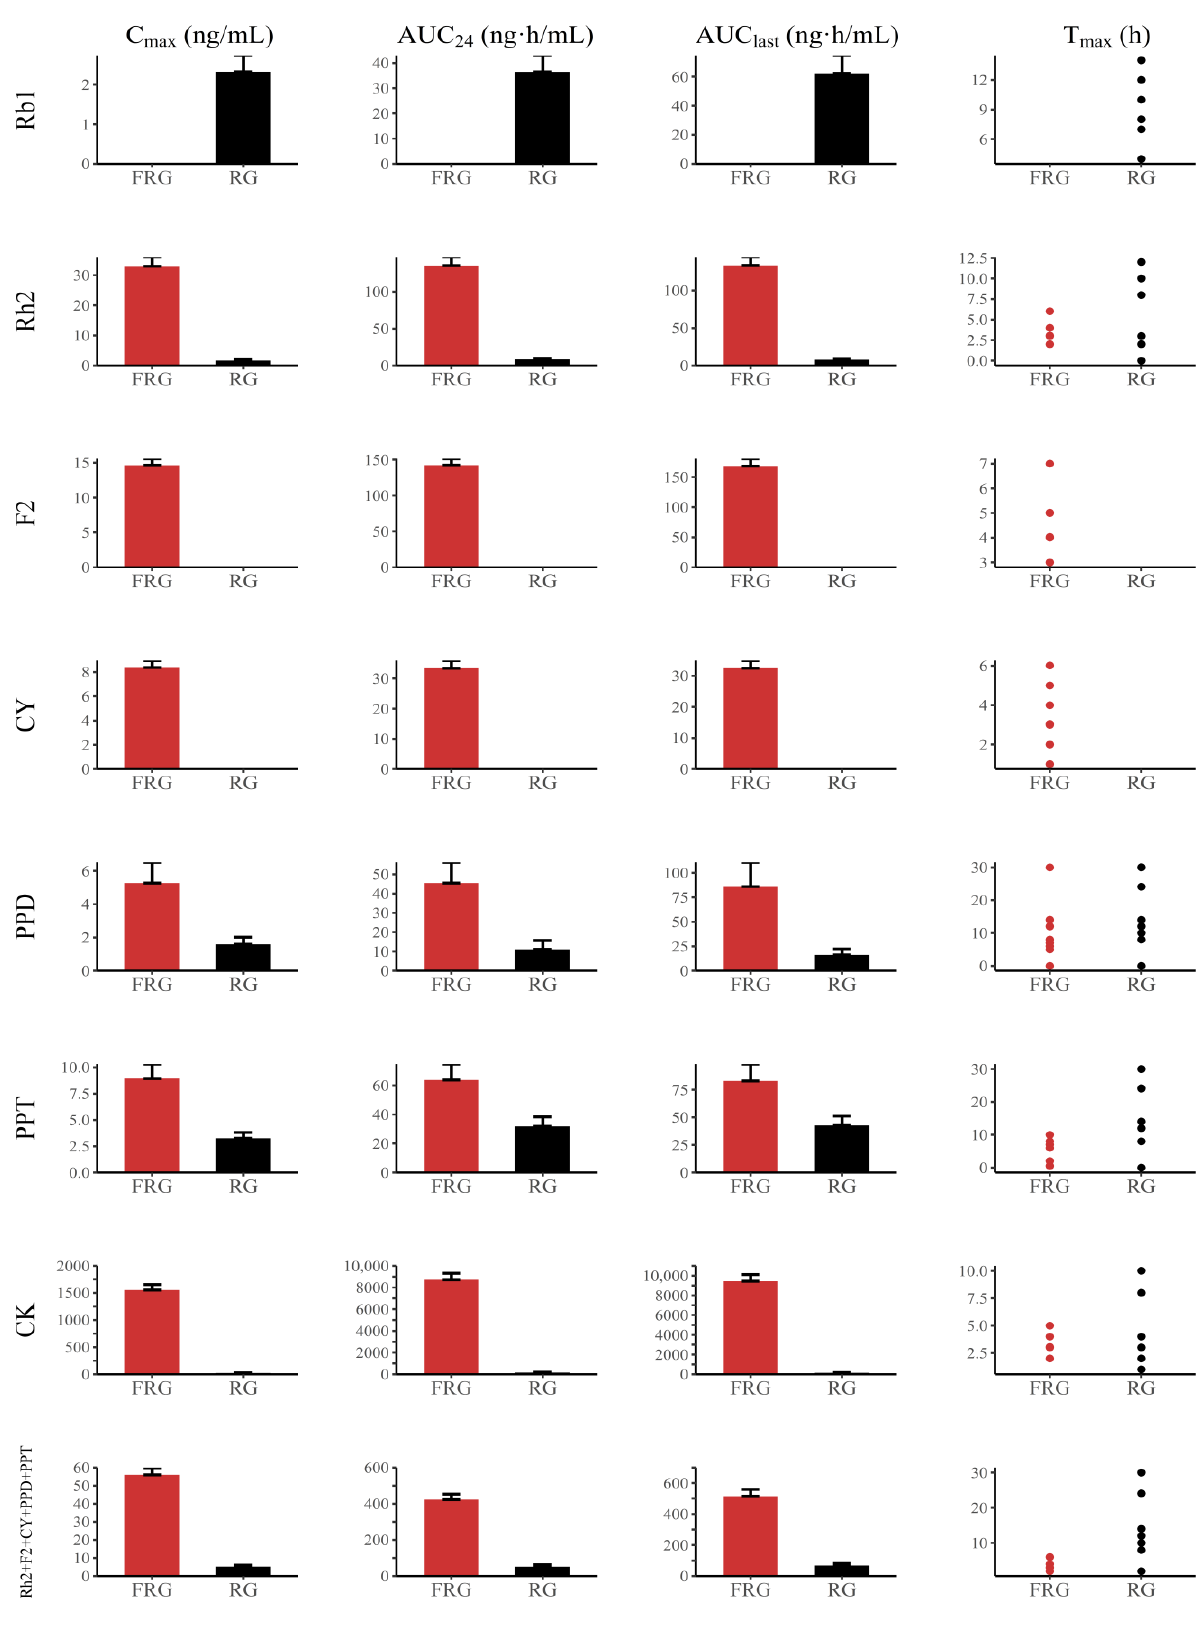
Figure 3. Pharmacokinetic comparisons of C max , AUC 24 , AUC last , and T max between fermented red ginseng (FRG) (red circles) and red ginseng (RG) (black circles).